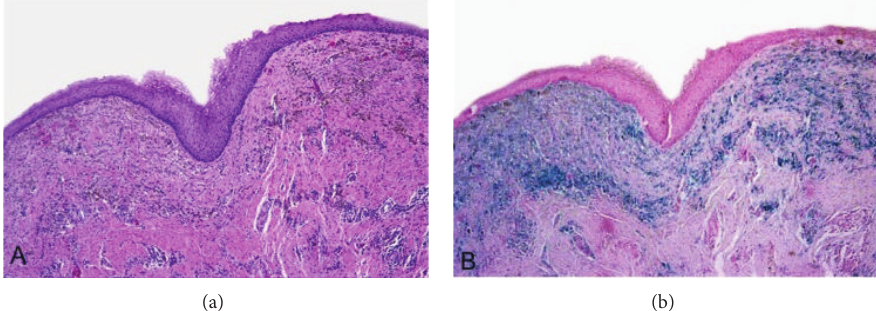
Figure 4: (a) Pigmented macrophages under stratified squamous epithelium. (b) This pigmented area consisted of blue colored hemosiderin and brown colored melanin ((a) hematoxylin and eosin and (b) Prussian blue, magnifications (a) and (b) ×